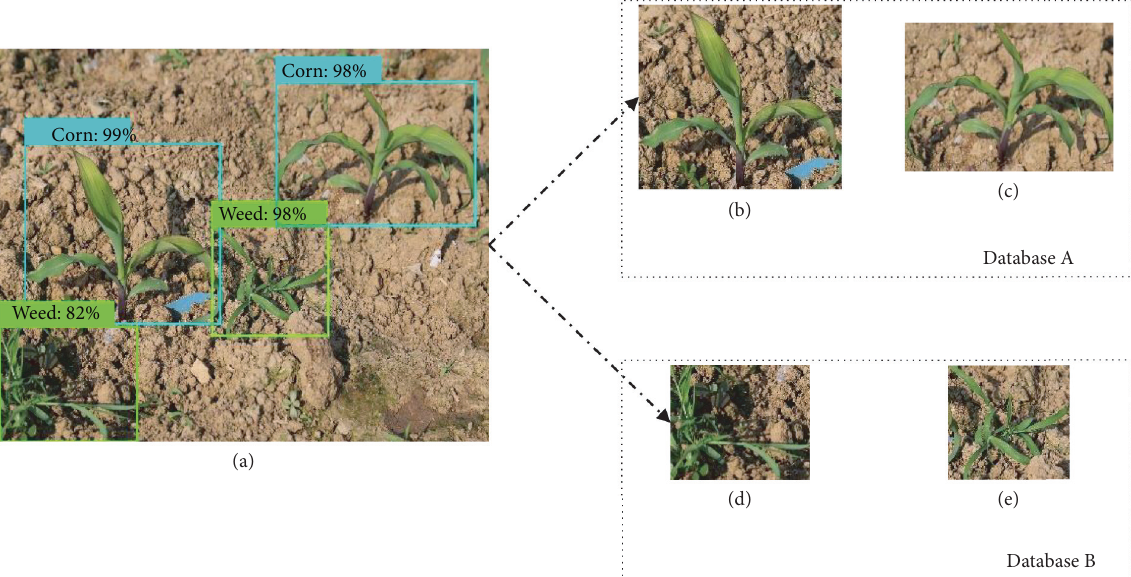
Figure 6: Schematic diagram of corn and weed recognition as well as automatic weed removing. (a) Recognition results of corn and weed. (b) and (c) Details of corn recognition results. (d) and (e) Details of weed recognition